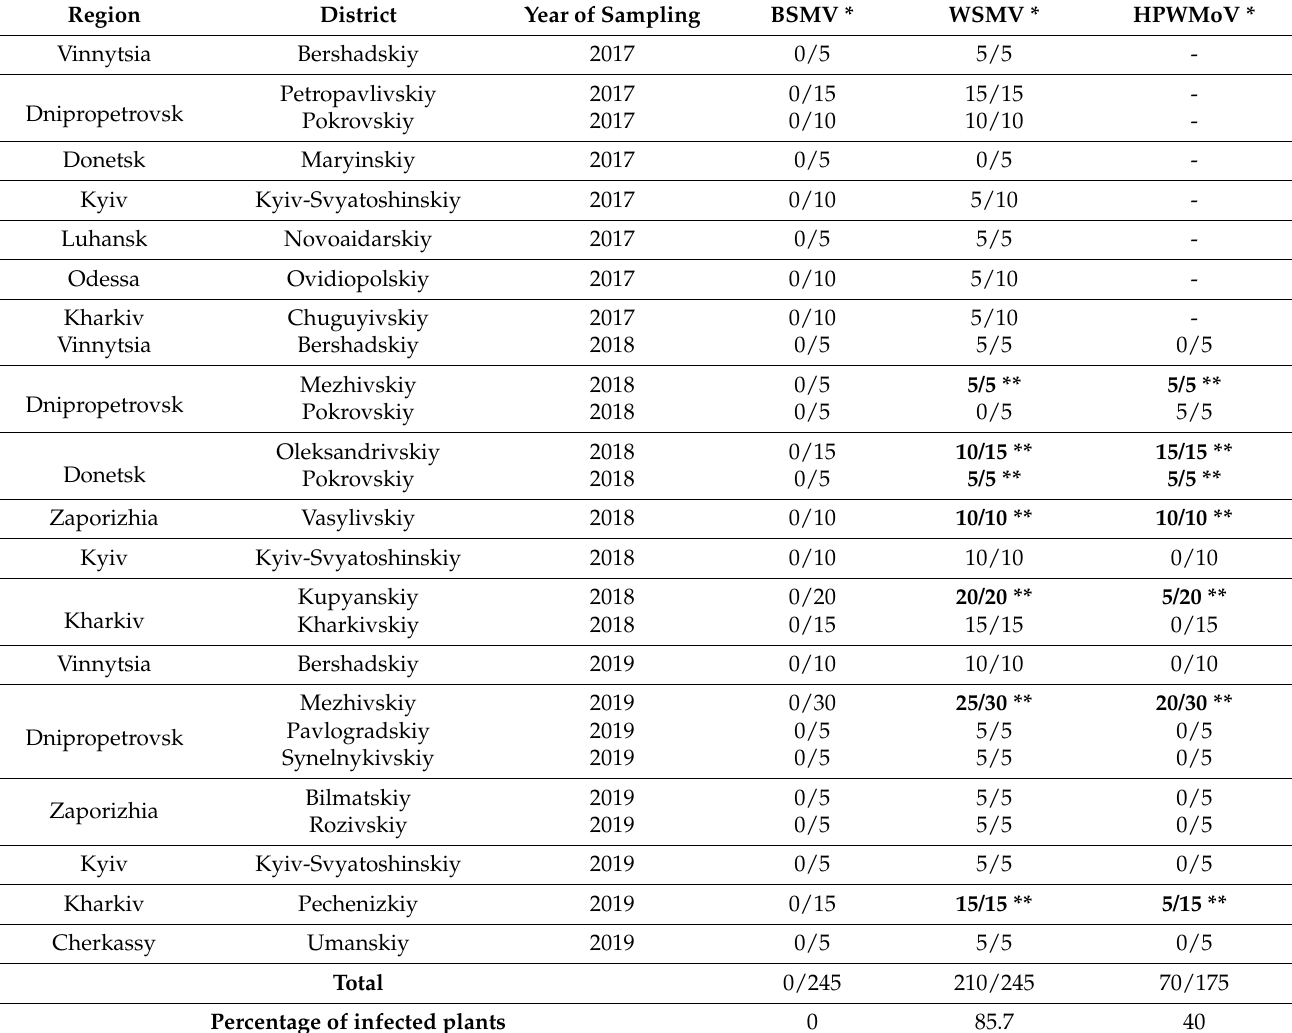
Table 2. Detection of WSMV, BSMV, and HPWMoV by DAS-ELISA in symptomatic winter wheat samples collected in 2017–2019 (mixed infection is shown in